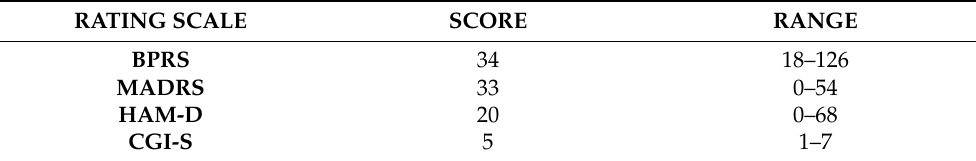
Table 2. Psychometric assessment at first consultation.